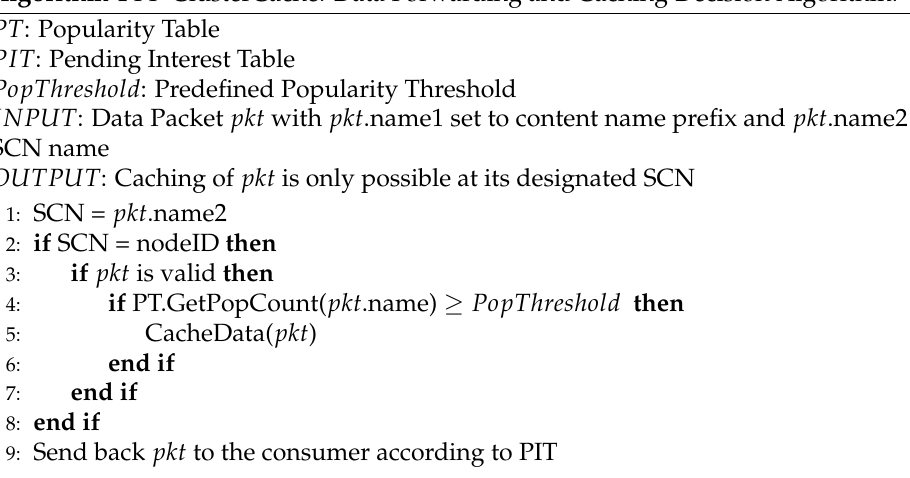
Algorithm 4 PF-ClusterCache: Data Forwarding and Caching Decision